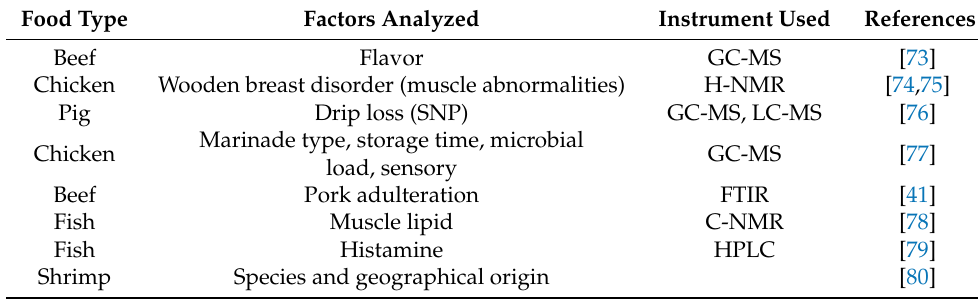
Table 4. Metabolomics approach performed on meat, fish, and seafood products. Food